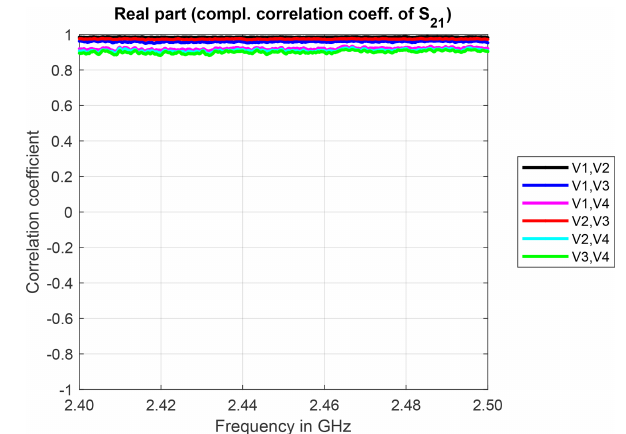
Figure 3. Real part of the complex correlation coefficients for iden- tically constructed antennas and measurement trial 4.